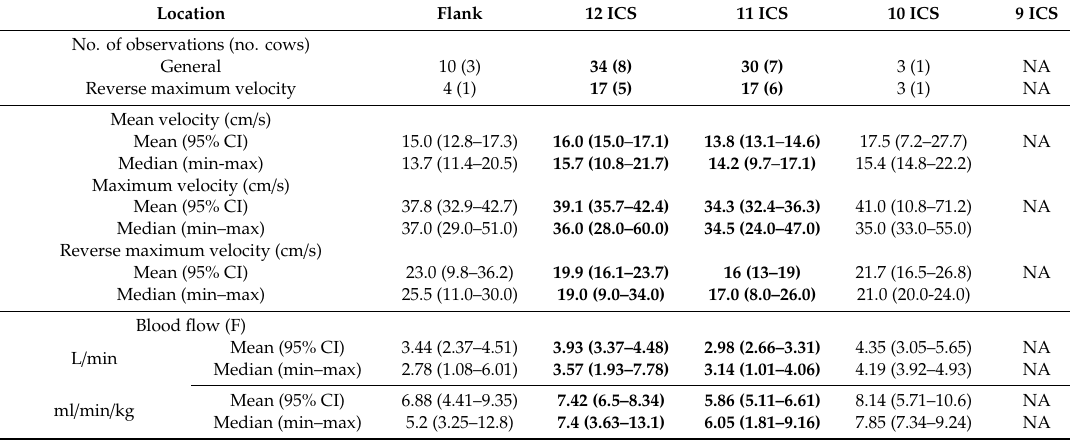
Figure 3. Doppler spectrum of the portal system, from afferent vessels to its main bifurcation within the liver. The images clearly show how portal flow changes from a mainly laminar to a turbulent flow, returning gradually to laminar. ( A ) splenic vein, ( B ) cranial mesenteric vein (Mes Cr), ( C ) main portal vein, and ( D ) right portal branch (Porta D). White arrowhead depicts maximum reverse flow in the main portal vein. Table 1. Results of ultrasonography examination of the cranial mesenteric vein expressed as mean (95% confidence interval) and median (minimum-maximum). Values obtained in the most frequent location are highlighted in bold.